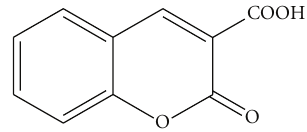
Figure 1: The structure of the ligand (coumarin-3-carboxylic acid, C3CA)